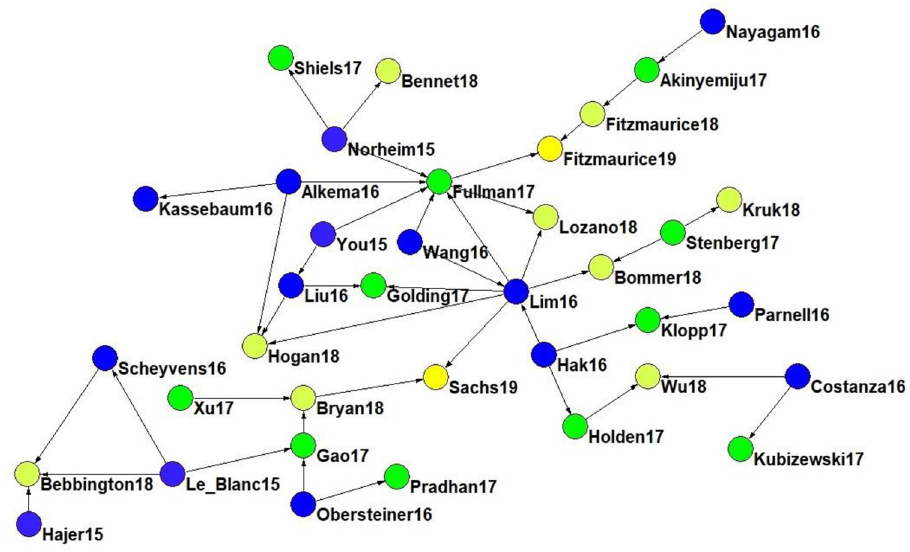
Fig 5. Cross-citation graph. Data source WoS.